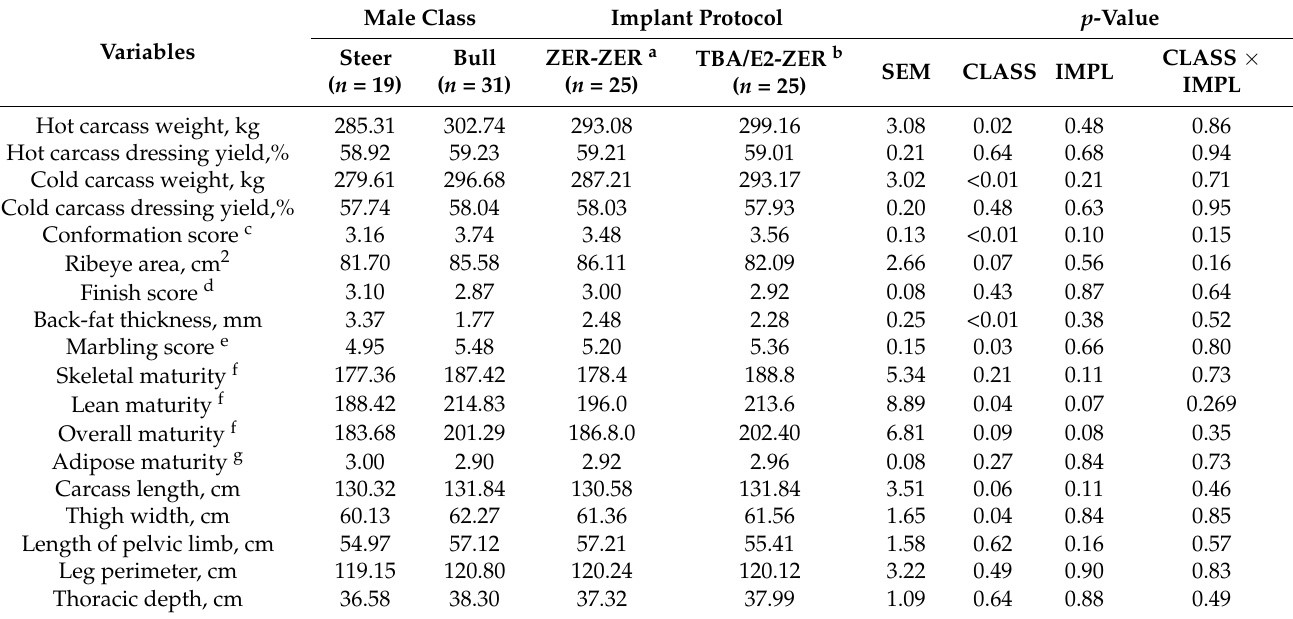
Table 7. Carcass traits according to male class and implant protocol (Experiment